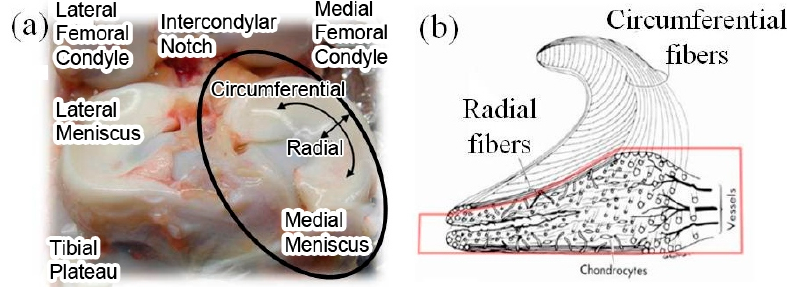
Figure 1. ( a ) Anatomical photograph of meniscus; ( b ) internal microstructure at cross-section. Figure 1 illustration of Human Knee Meniscus (adapted from [1,2]).